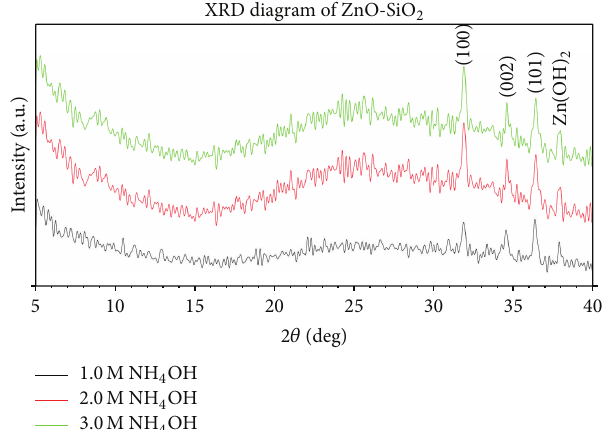
Figure 9: X-ray diffraction plot of the as-grown ZnO-SiO 2 on glass substrate using 1.0 M (black), 2.0 M (red), and 3.0 M (green) NH 4